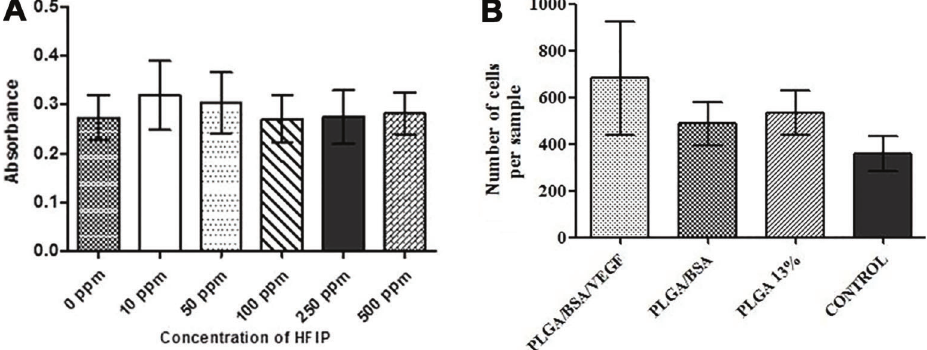
Figure 5. A , Evaluation of the metabolically active cells by MTT after cultivation in a DMEM medium with various concentrations of 1,1,1,3,3,3-hexa fl uoro-2-propanol (HFIP) solvent (repeated measures with post-hoc Bonferroni). B , Cellular adhesion after 6 h of cultivation in vitro for 5 primary cultures of human adipose derived stem cells tested on the following scaffold groups: PLGA/BSA/VEGF, PLGA/BSA, 13% PLGA and the control (cells cultivated directly on the cultivation plate wells) (one-way ANOVA with post-hoc Tukey ’ s test). Data are reported as means ± SE. PLGA: PLGA: polylactic-co-glycolic acid; BSA: bovine serum albumin; VEGF: vascular endothelial growth factor.